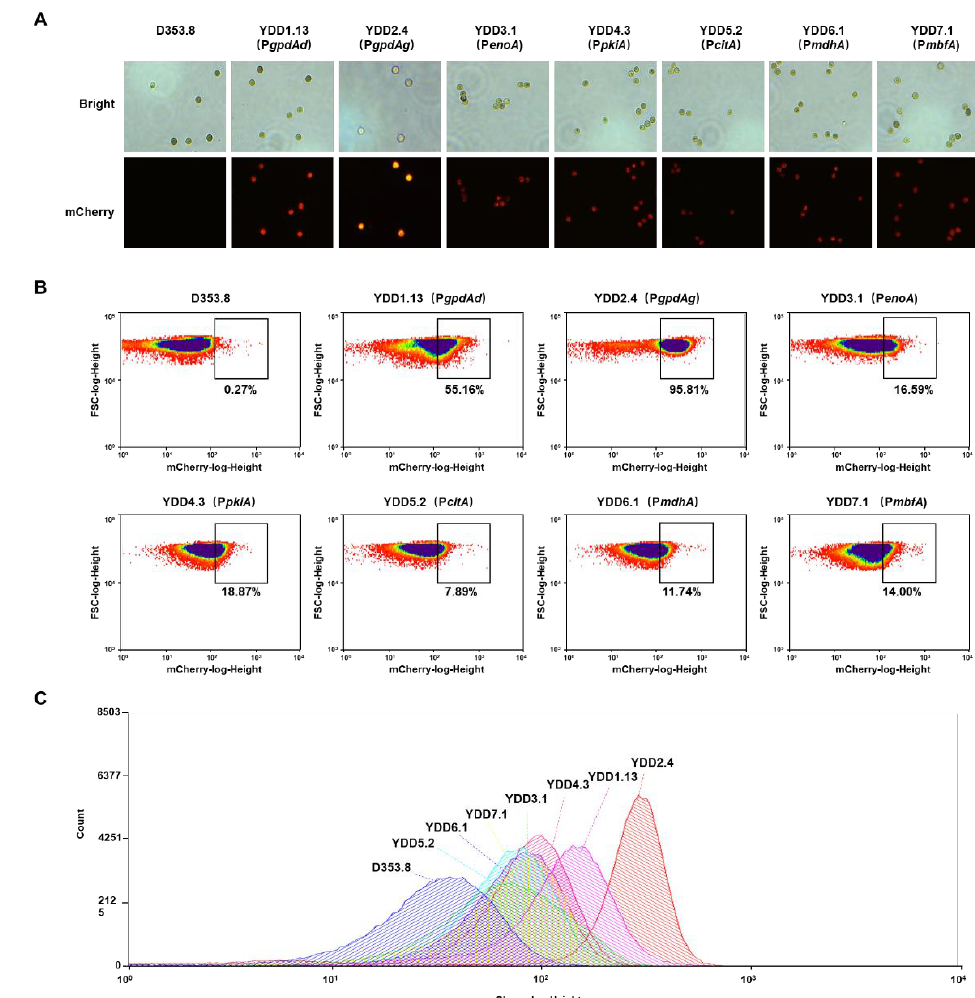
Figure 2. Fluorescence analysis of constructs expressing mCherry-pyrG controlled by six constitutive promoters. ( A ) Representative fluorescence images in conidia of constructs expressing mCherry-pyrG controlled by six constitutive promoters. The parent strain D353.8 was used as negative control and YDD1.13 was used as positive control. ( B , C ) Representative flow cytometry analysis of the conidia of constructs YDD2 to YDD7 expressing mCherry-pyrG controlled by six selected promoters. The 100,000 spores were analyzed by flow cytometry. To reduce the interference of background fluorescence from the parent strain D353.8, the black box marking the same value of mCherry-log- height (higher than 10 2 ) was used for direct comparison of constructs expressing mCherry-pyrG controlled by different promoters. The number below the black box represents the percentage of spores with high fluorescence (mCherry-log-height higher than 10 2 ) of each construct. A. niger YDD1.13 with the promoter of PgpdAd was used as positive control, while the parent strain D353.8 was used as negative